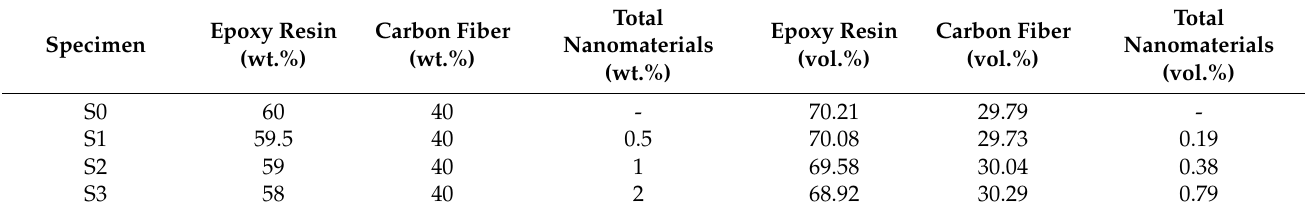
Table 8. Weight and volume percentage of all